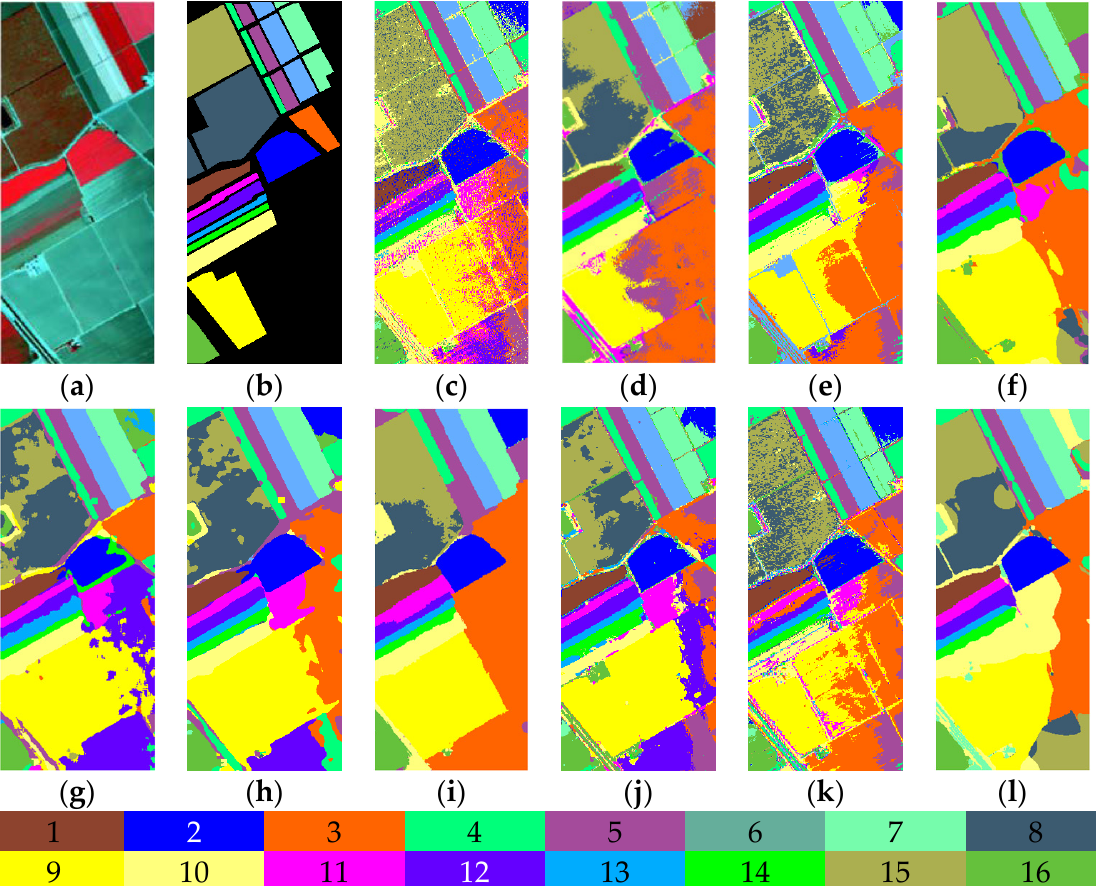
Figure 3. Salinas dataset. ( a ) False color composite image; ( b ) Ground truth image; ( c ) SVM; ( d ) LCMR; ( e ) RPNet; ( f ) MSTV; ( g ) GTR; ( h ) DBDA; ( i ) FDSI; ( j ) 𝑙 (cid:2868) - 𝑙 (cid:2869) HTV; ( k ) SpectralFormer; ( l ) Our method. Color illustrations of all classes are shown below.